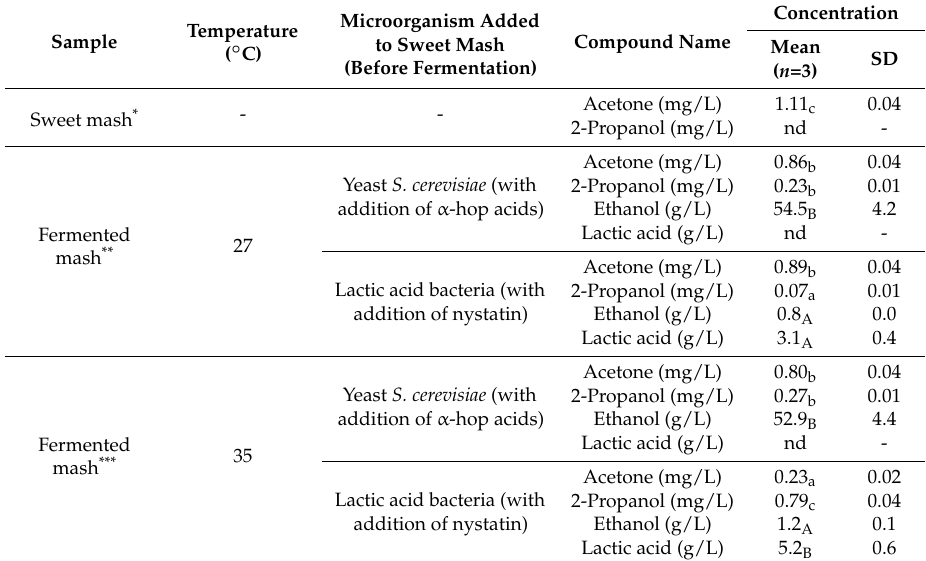
Table 5. Acetone, 2-propanol, ethanol, and lactic acid contents in the sweet and fermented